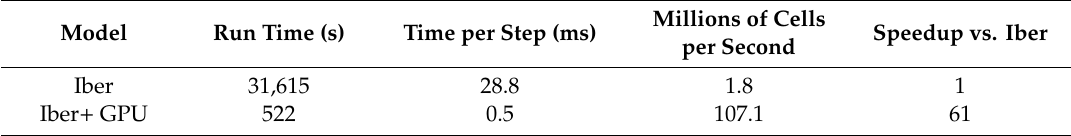
Table 2. Performance measurements obtained for the second test case (estuary of A